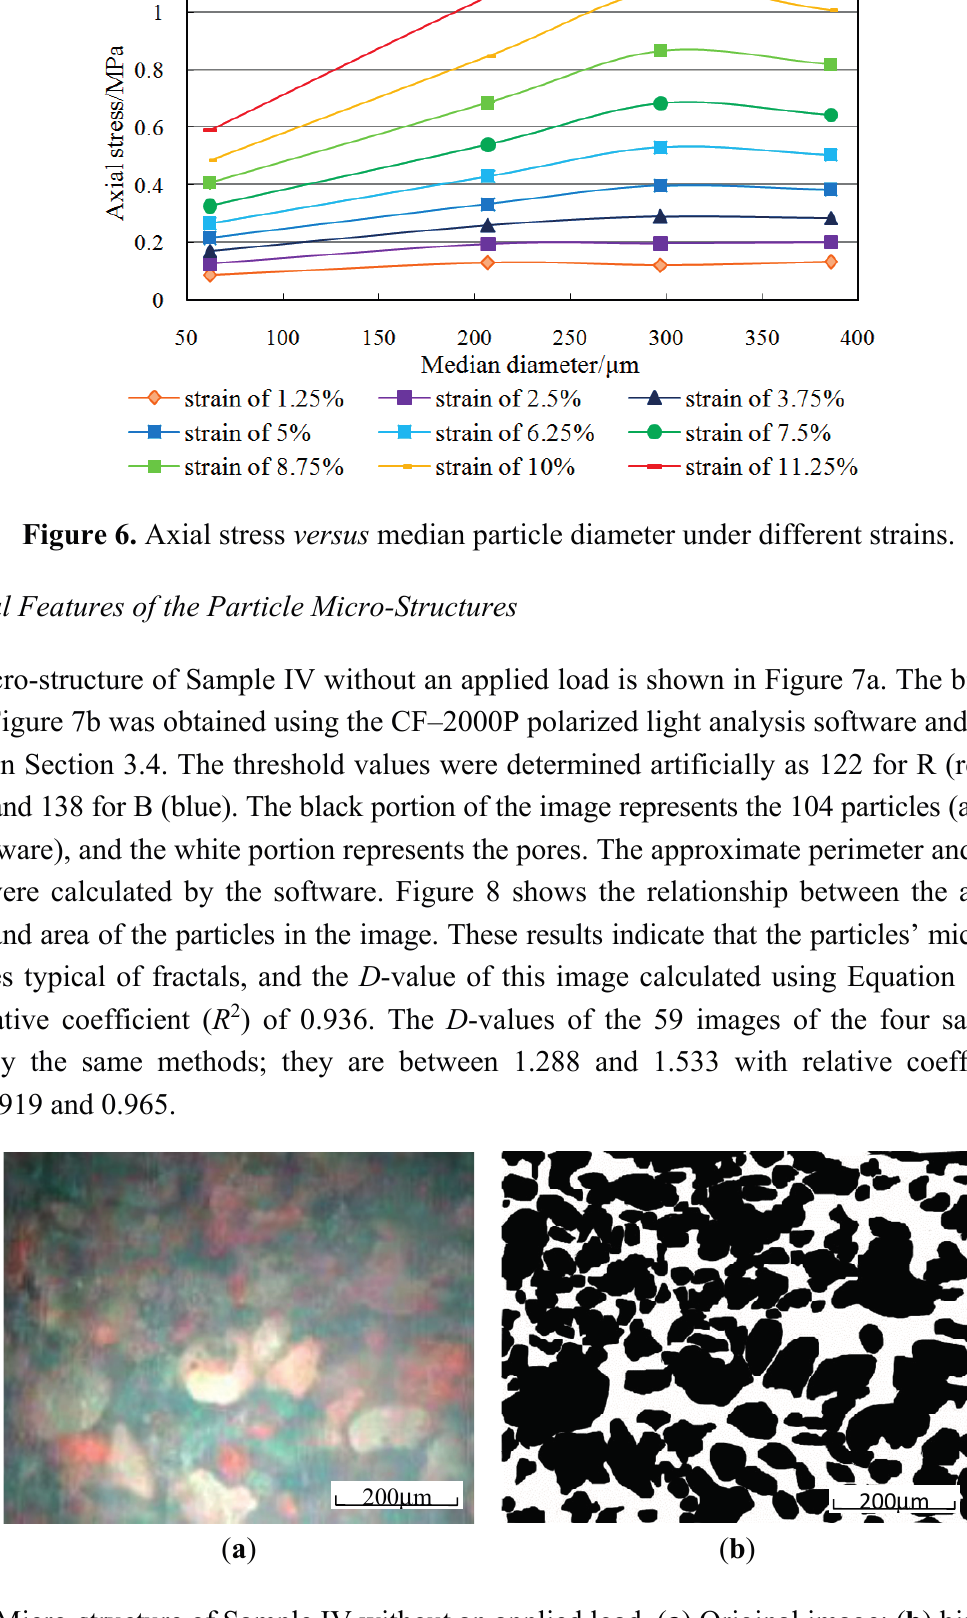
Figure 7. Micro-structure of Sample IV without an applied load. ( a ) Original image; ( b ) binary